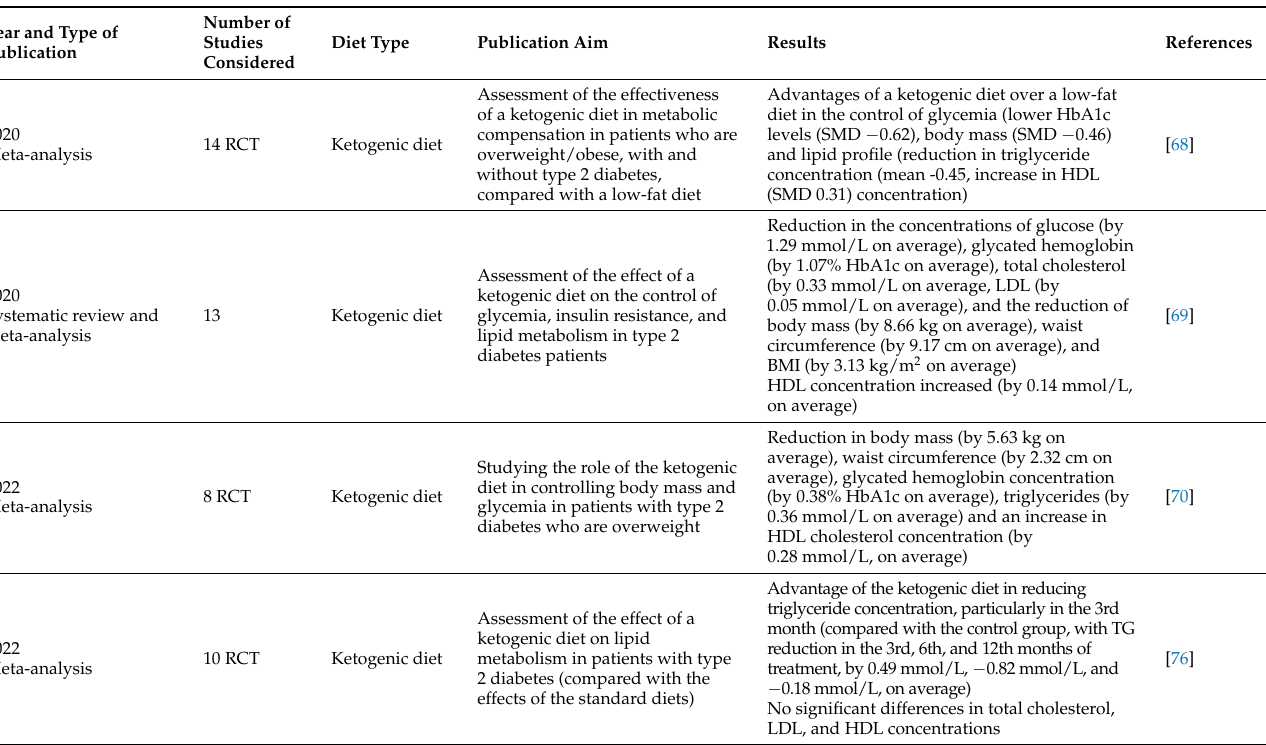
Figure 2. Flowchart presenting the study selection according to PRISMA guidelines. Table 3. Summary of the meta-analyses and systematic reviews concerning the effect of a ketogenic diet on patients with type 2 diabetes.